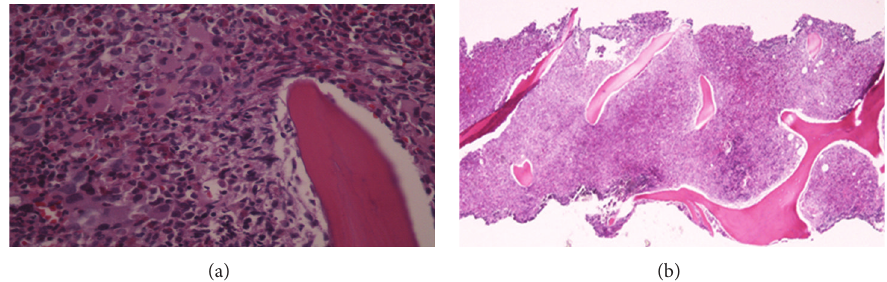
Figure 3: Bone marrow biopsy showing a hyper cellular marrow with increased myeloid cells in all maturation